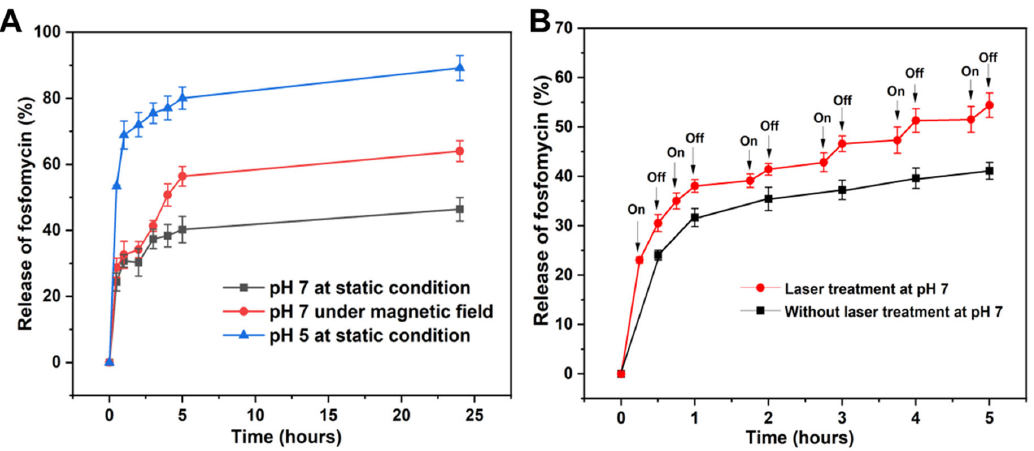
Figure 5. Release profile of fosfomycin from Fe 3 O 4 @PDA HR at different pH and upon the exposure to a rotational magnetic field ( A ) and upon NIR laser irradiation ( B ).